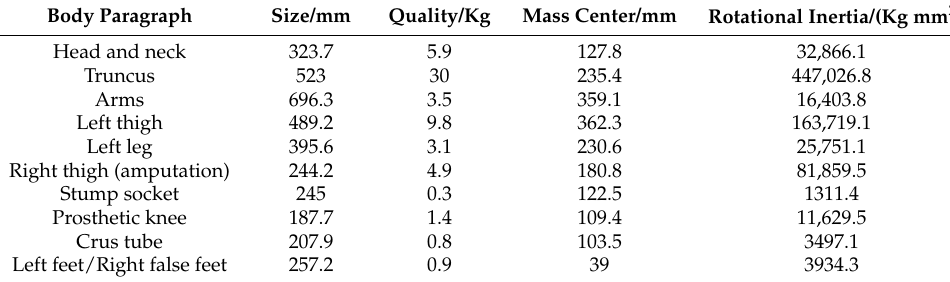
Table 2. Human body parameters setting in